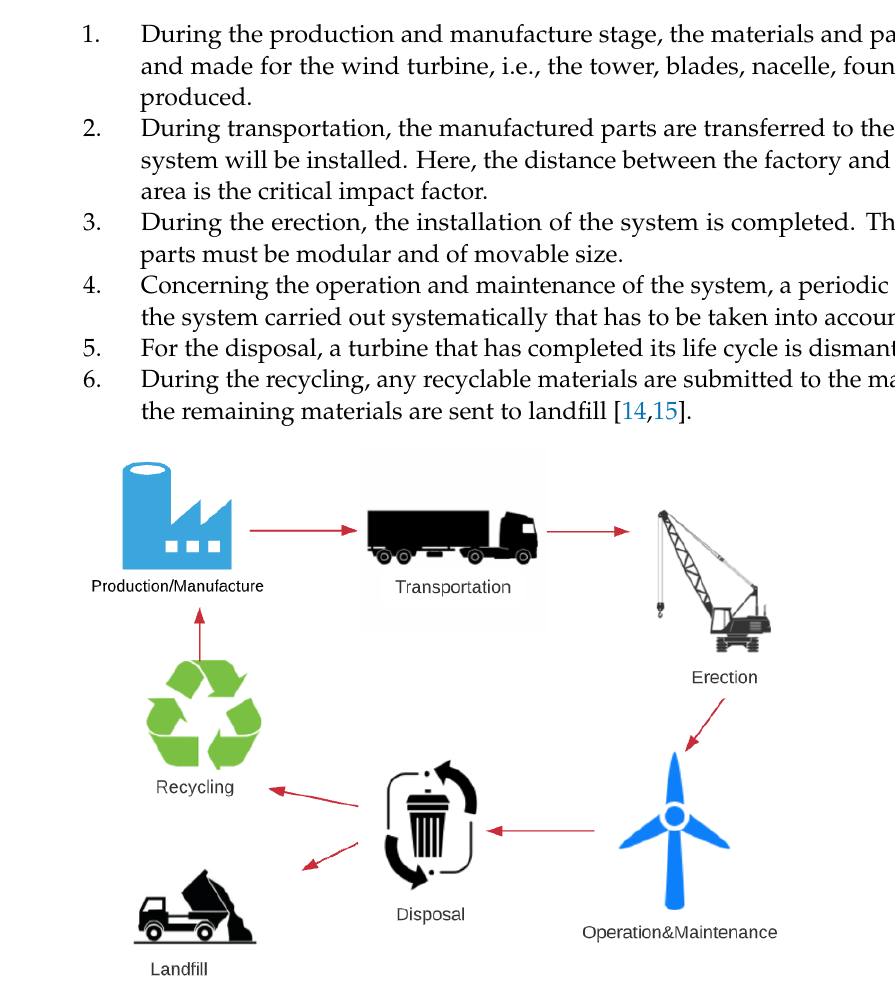
Figure 1. Life cycle assessment stages of a wind energy system.